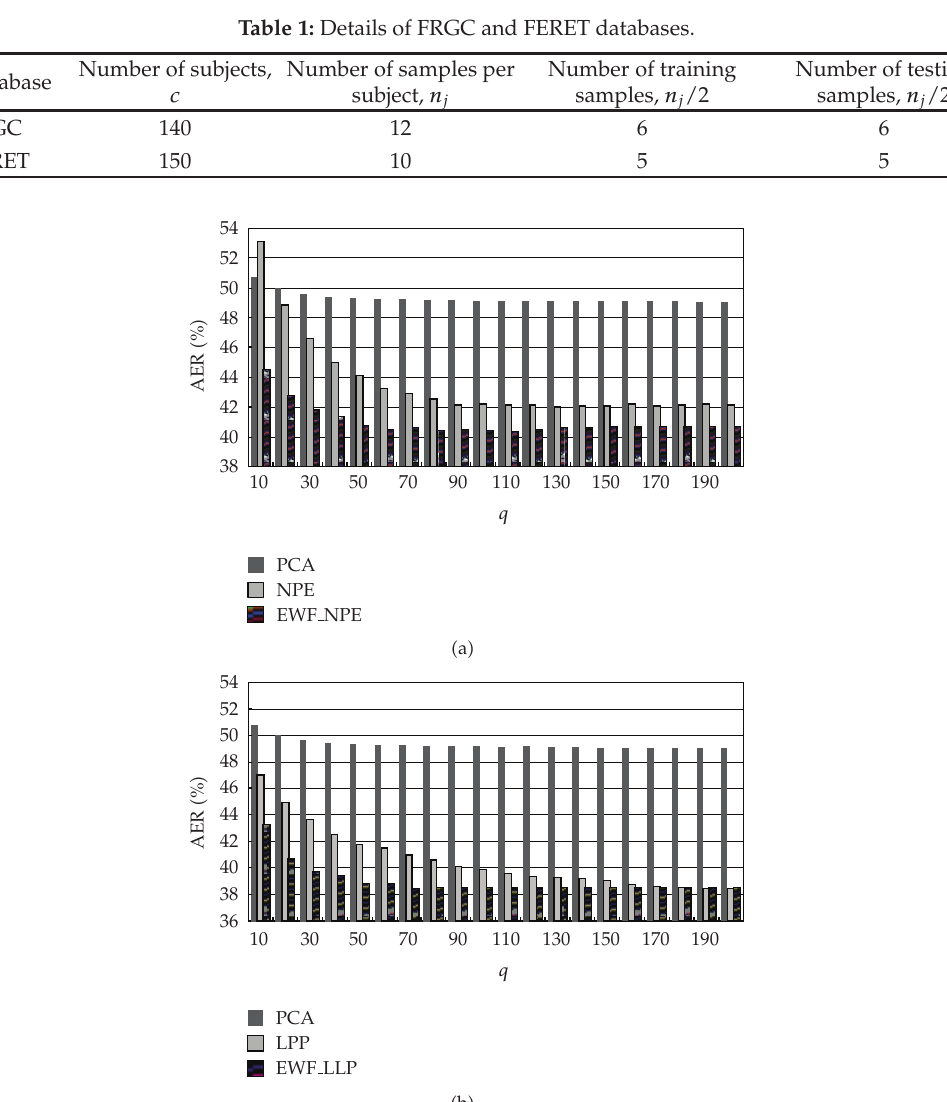
Figure 12: Error rates (cid:2) % (cid:3) of (cid:2) a (cid:3) PCA, NPE and EWF NPE, (cid:2) b (cid:3) PCA, LPP and EWF LPP on FRGC database.